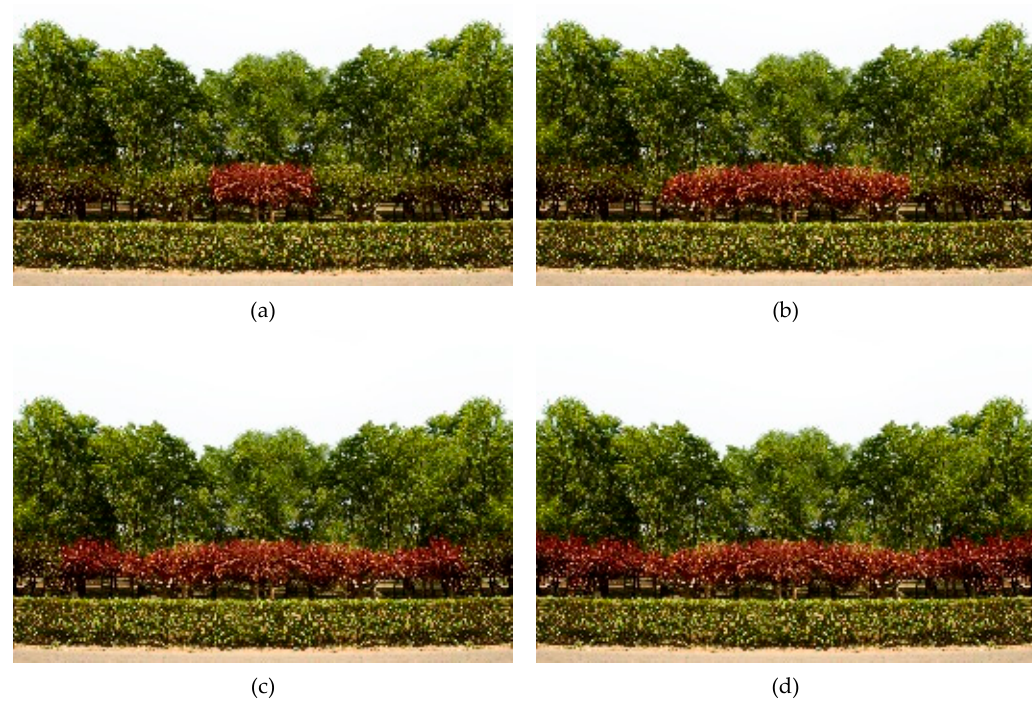
Figure 2 . Examples of different design red color proportions in the midground of Prunus cerasifera in a soft landscape of Sophora japonica in the background and Euonymus japonicus in the foreground. ( a ) C 25 accounts for 25% red of the midground; ( b ) C 50 accounts for 50% red of the midground; ( c ) C 75 accounts for 75% red of the midground; ( d ) C 100 accounts for 100% red of the midground.